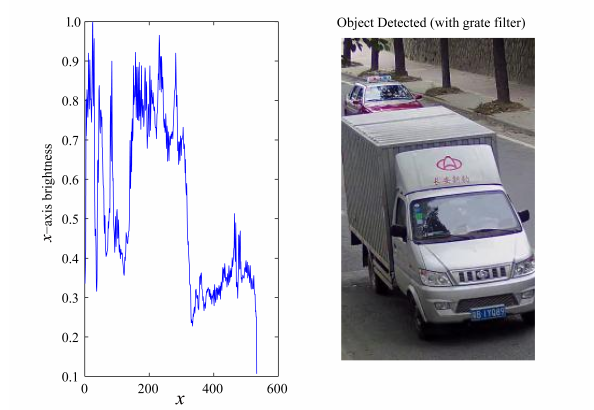
Fig. 4 Horizontal axis’ brightness values and identified result (with bar filter).